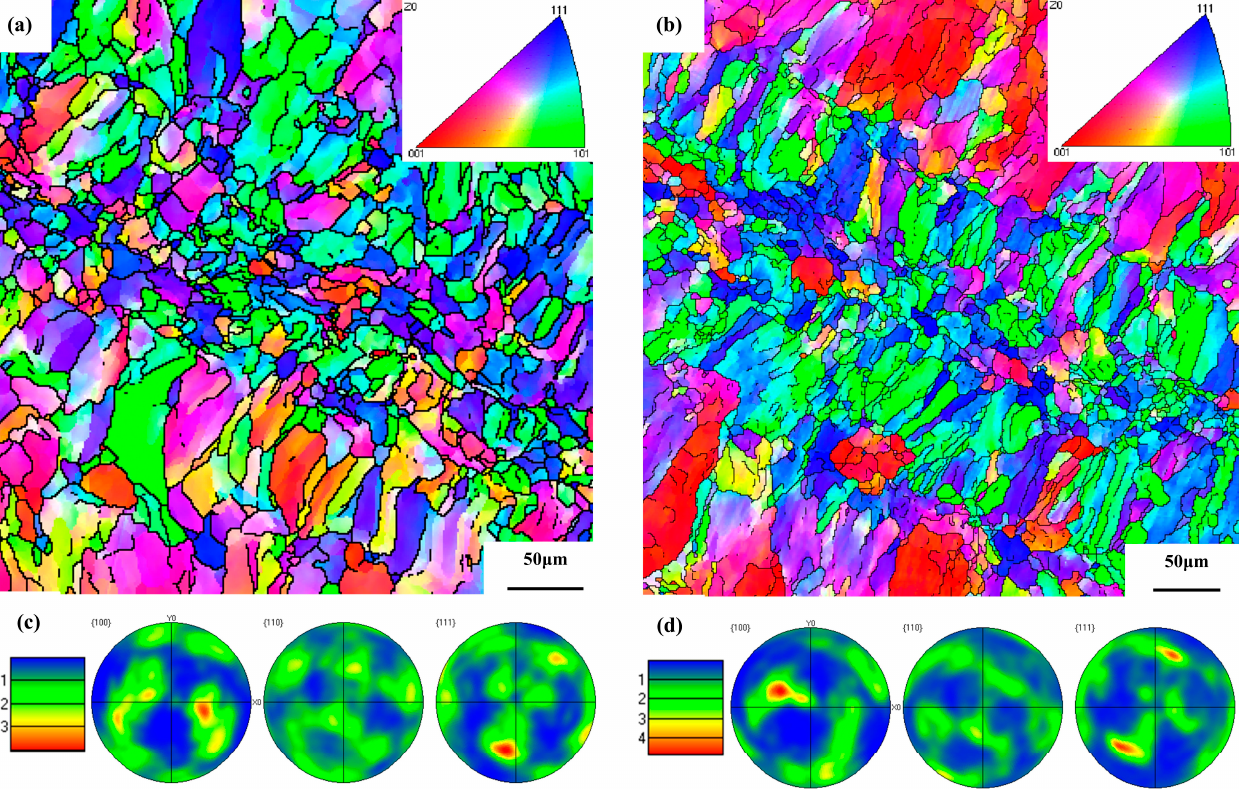
Figure 10. EBSD analysis of cross-sections of top ( a , c ) and bottom ( b , d ) of thin-wall cladding, ( c , d ) pole figure of ( a , b ).